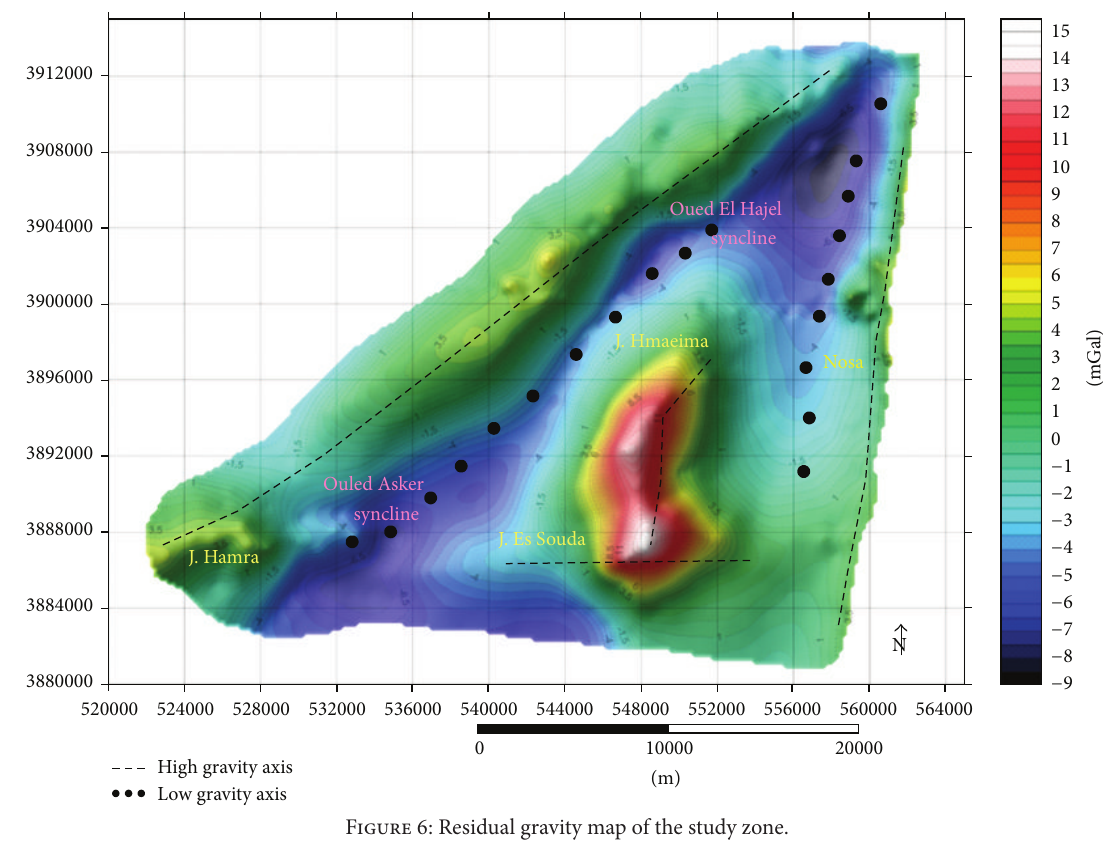
Figure 6: Residual gravity map of the study zone.